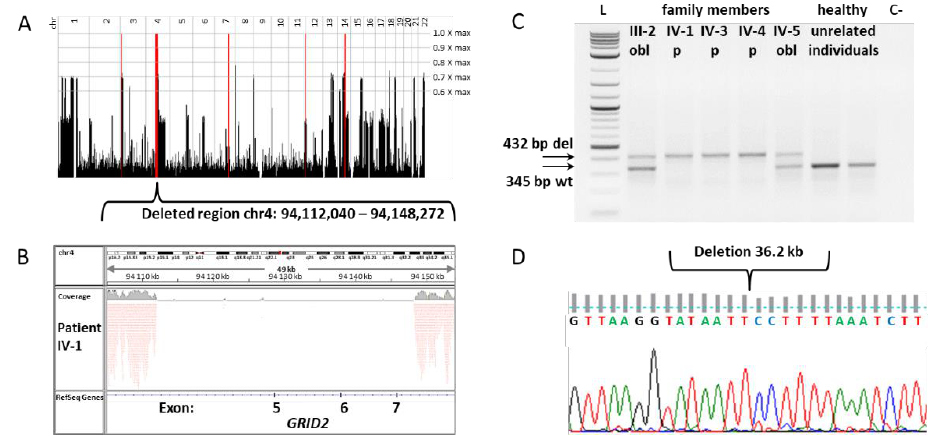
Figure 2. Identification of deletion in GRID2 gene in consanguineous Brazilian family: ( A ) Loci of homozygosity in three patients (marked in red) (IV-1, IV-2, and IV-3); ( B ) visualization of genomic region of deletion covering 5 – 7 exons of GRID2 gene in whole-genome sequencing data of the patient IV-1 (Integrative Genomics Viewer image); ( C ) electropherogram of PCR validation of the deletion in GRID2 gene: L — DNA ladder. Due to the large deletion region of 36.2 kb, the PCR reaction was performed using two primer pairs with one common forward and two different reverse oligonucleotides. The first primer pair annealed on flanking genomic sequences across deletion and produced a 432 bp fragment corresponding to patients bearing 36.2 kb deletion. The second primer pair annealed on the 5′ flanking region and on a genomic sequence within the deletion region, and produced a 345 bp fragment found in healthy individuals. Both PCR products were identified in obligate carriers: mother—III-2, and healthy son—IV-5; ( D ) validation of deletion in GRID2 gene